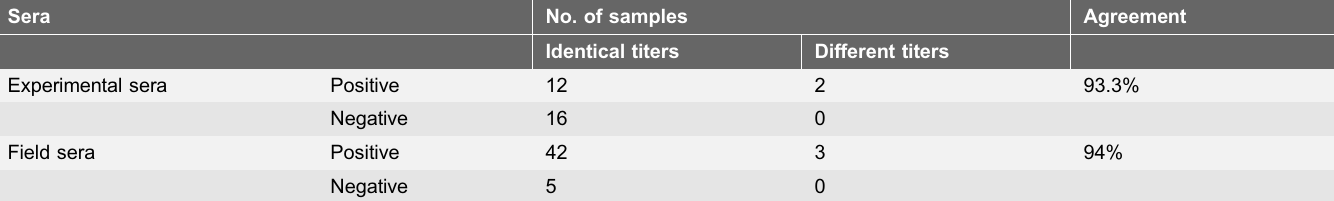
Table 1. Agreement between ALV-J-specific neutralizing antibody titers determined by NIT and NT-EGFP.